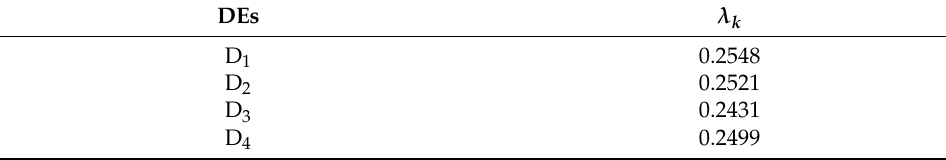
Table 9. The weight of